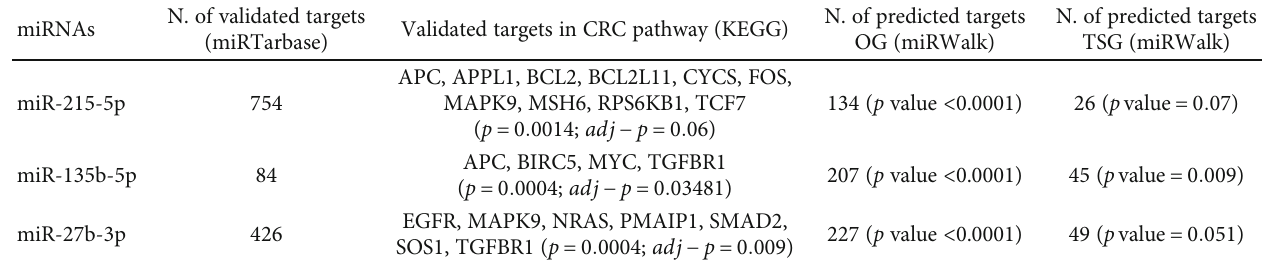
OG: oncogenes; TSG: tumor suppressor gene. p value has been calculated using the Fisher exact